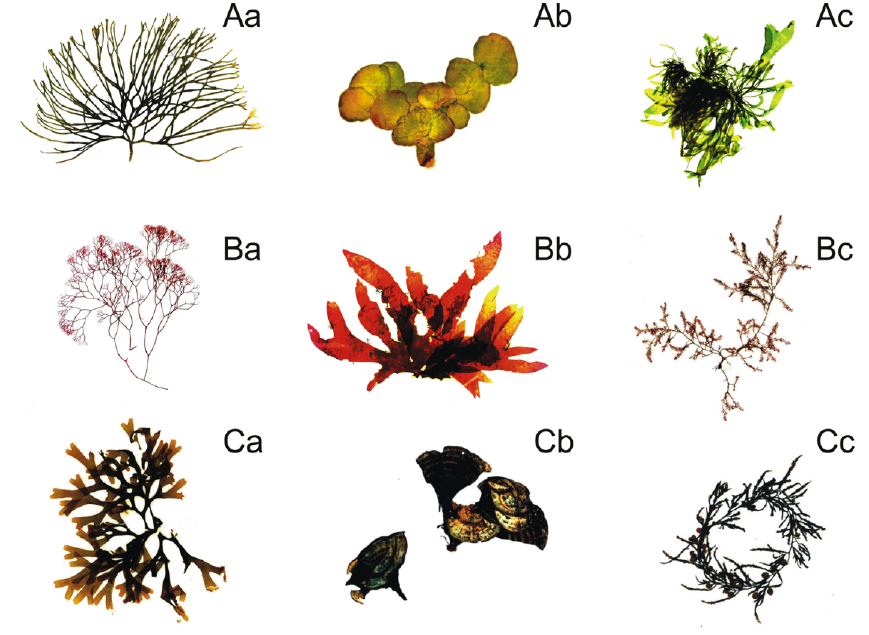
Figure 1. Examples of allelopathic green algae ( A ): Codium fragile ( a ), Halimeda tuna ( b ), Ulva sp. ( c ); red algae. ( B ): Ceramium rubrum ( a ), Grateloupia sp. ( b ), Polysiphonia sp. ( c ); brown algae. ( C ): Dictyota sp. ( a ), Padina sp. ( b ), Sargassum sp. ( c